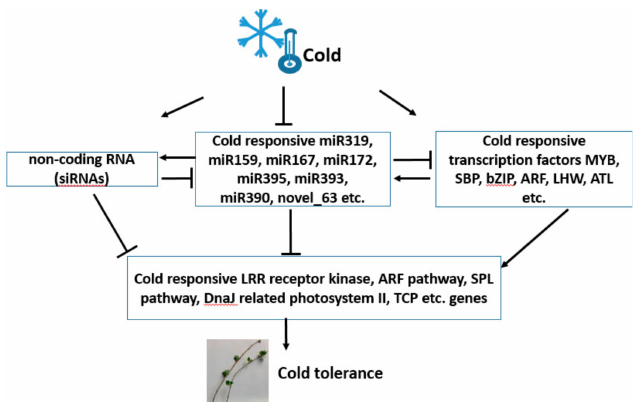
Figure 8. A putative cold responsive regulation model of sRNAs and their targets in Populus simonii × P.